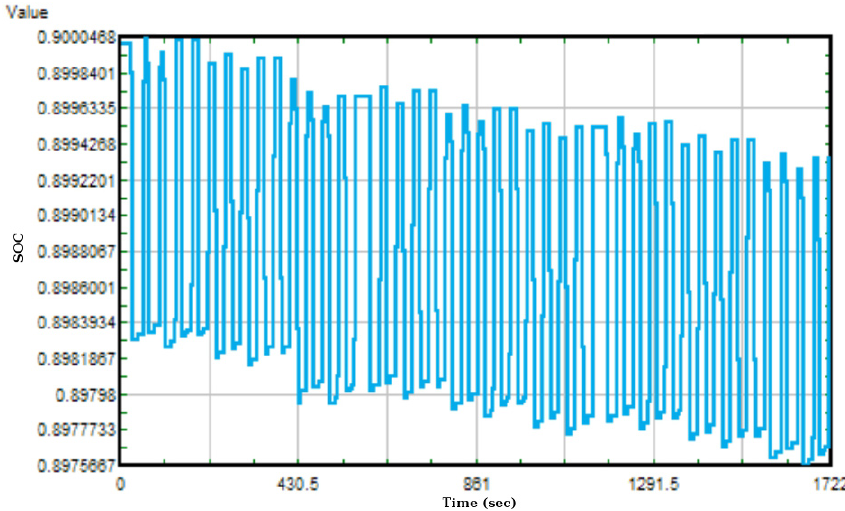
Figure 8. State of charge of battery in PHEV model.